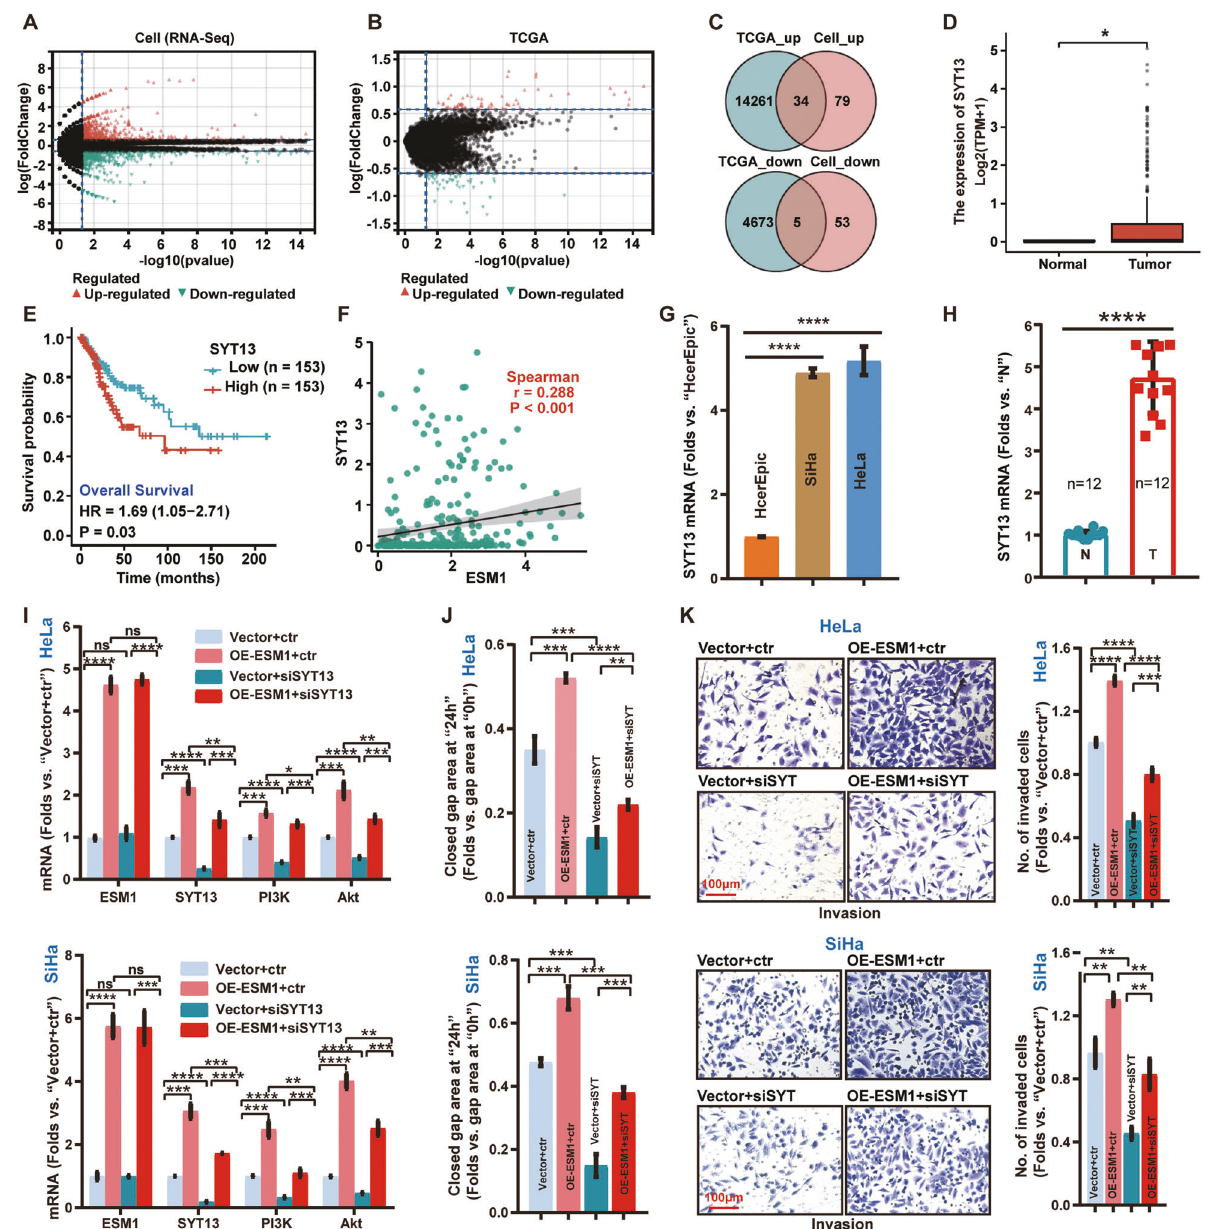
Fig. 5 ESM1 activates the PI3K signaling pathway via up-regulating SYT13 expression in cervical cancer cells. RNA sequencing revealed differential expression genes (DEGs) between in ESM1-overexpressed ( “ OE-ESM1 ” ) and vector control ( “ Vector ” ) SiHa cells ( A ); DEGs based on ESM1 expression in TCGA cervical cancer tissues ( B ). Venn diagram of common upregulated and downregulated genes in TCGA database and modi fi ed cells ( C ). SYT13 mRNA expression in cervical cancer tissues ( n = 306) and in normal tissues ( n = 13) from TCGA database ( D ). Overall survival in cervical cancer patients with different ESM1 expressions ( E ). Correlation between ESM1 and SYT13 expression in TCGA cervical cancer tissues ( F ). SYT13 mRNA expression in cervical cancer cells and cervical epithelial cells was tested ( G ). SYT13 mRNA expression in cervical cancer ( “ T ” , n = 12) and adjacent normal cervical tissues ( “ N ” , n = 12) was tested ( H ). ESM1-overexpressed ( “ OE-ESM1 ” ) and vector control ( “ Vector ” ) cervical cancer cells were further transfected with SYT13 siRNA ( “ siSYT13 ” ) or scramble control siRNA ( “ ctr ” ) for 48 h, expression of listed mRNAs was shown ( I ); In vitro cell migration and invasion were tested ( J and K ), and results were quanti fi ed. The data were presented as mean ± standard deviation (SD, n = 3). * P < 0.05, ** P < 0.01, *** P < 0.001, **** P < 0.0001. The experiments were repeated three times with similar results obtained. Scale bar = 100 μ